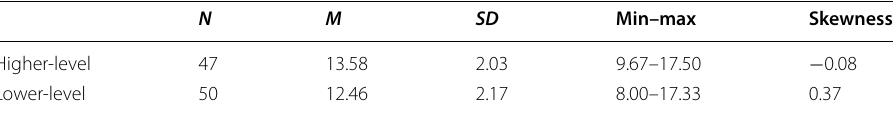
Note. The possible minimum and maximum scores were 4 and 20,